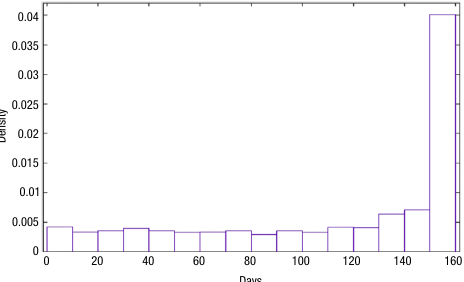
Fig. 7. Histogram of periods resulting from Periods Complex Test for periods < 161, source: own